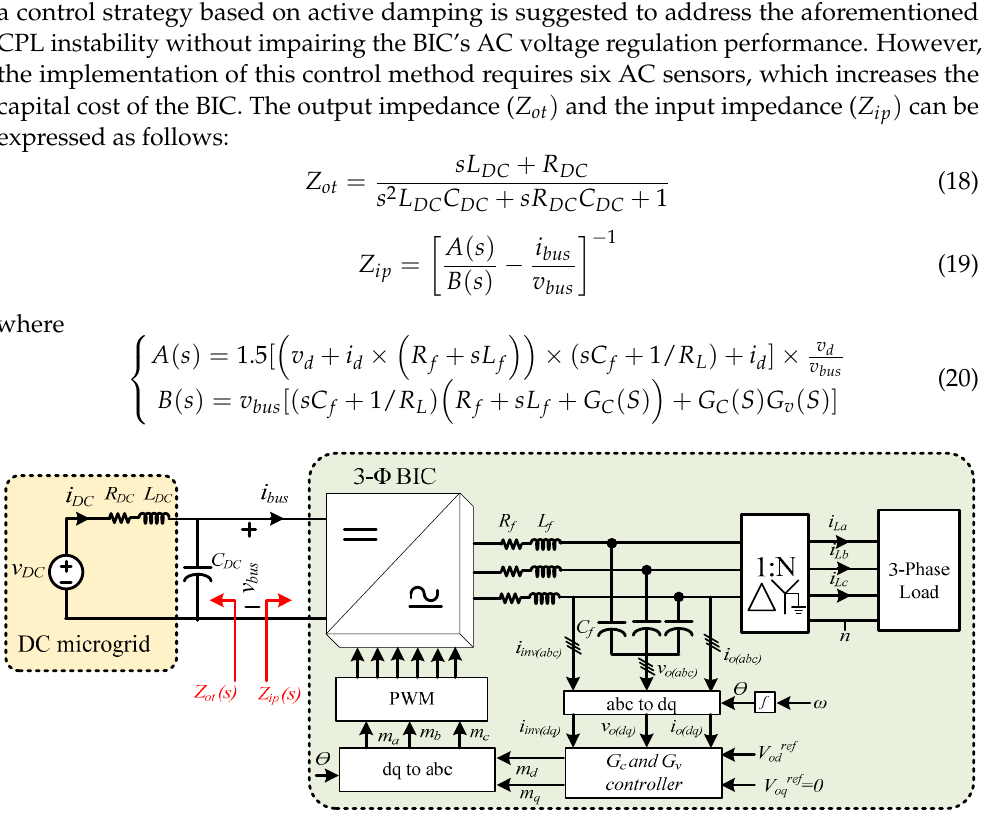
Figure 15. Cascaded system given in [95].